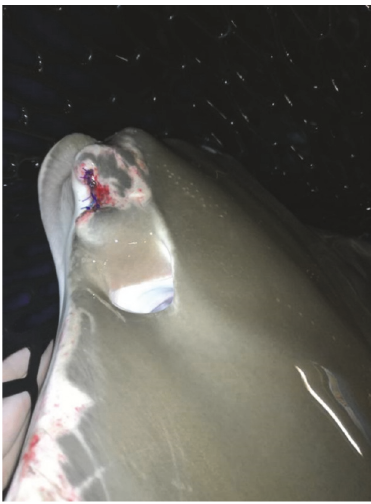
Figure 11: Day 7 after enucleation. There was no suture break, no skin discolouration, and no fungal growth on the surgical wound. Besides, the abrasion on the left cranial margin of pectoral fin was healing well with white fibrous scar tissue. According to the caretaker, she was having good appetite after